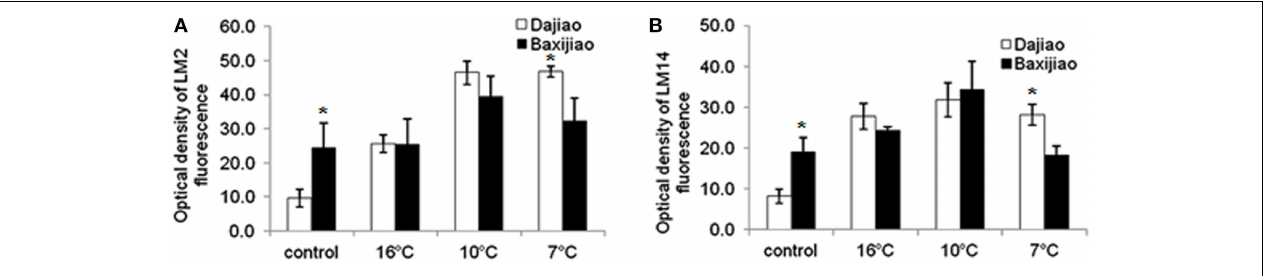
FIGURE 6 | The optical density of the fluorescence signal of arabinogalactan proteins labeled by LM2 and LM14 antibodies in banana ( Musa spp.) leaves after low temperature stress. (A) LM2: (B) LM14. Dajiao: a Musa spp. ABB cultivar,